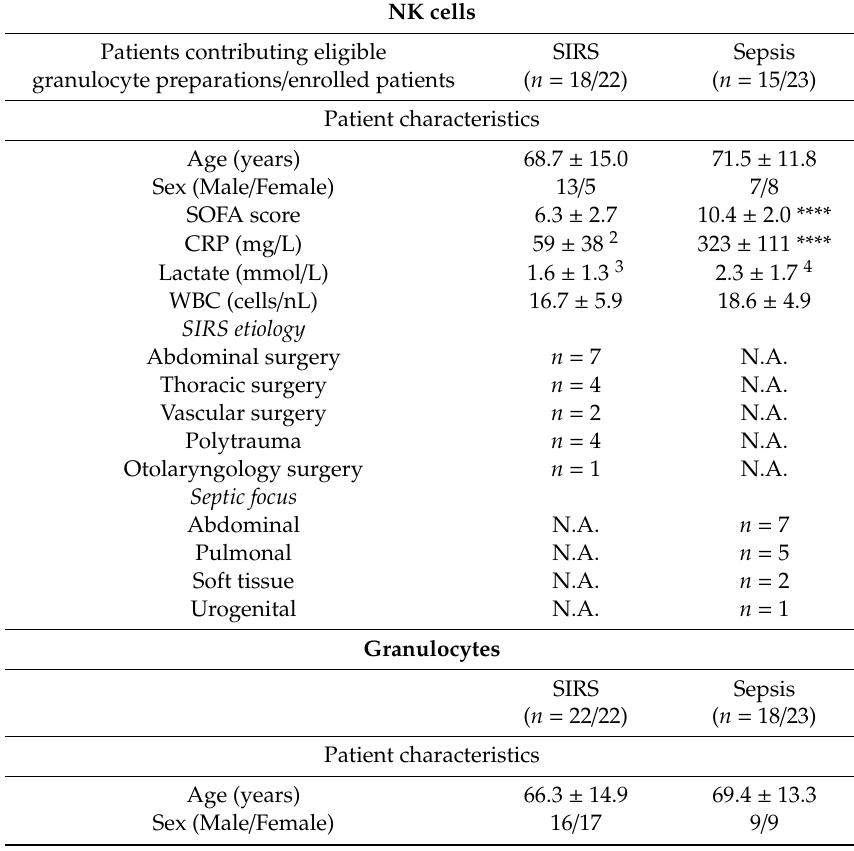
Table 2. Patient characteristics for NK cells and granulocytes for the validation set 1